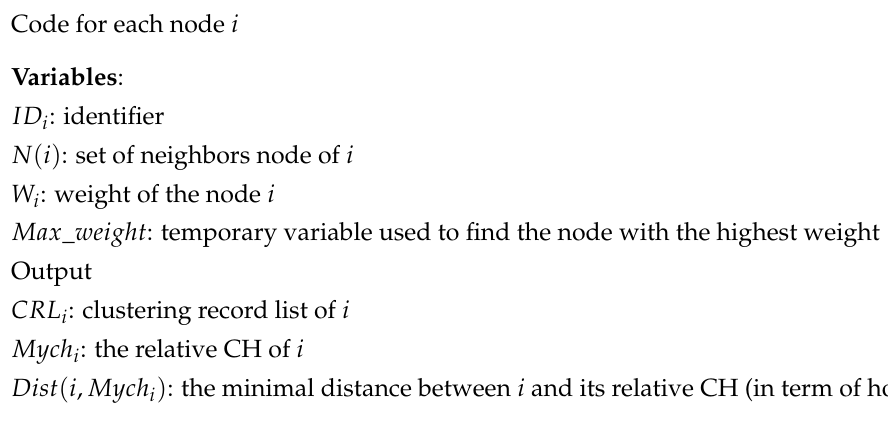
Algorithm 2 Cluster Head election